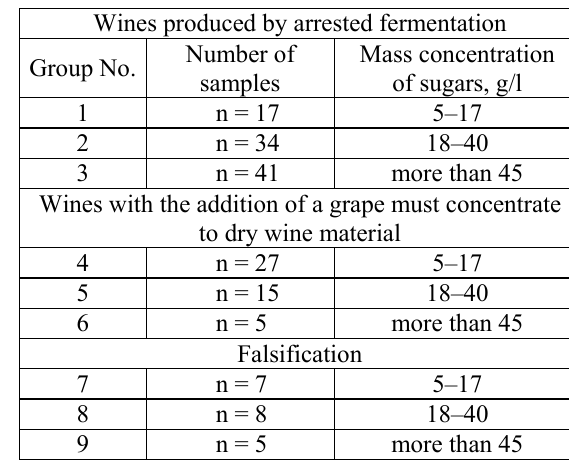
Table 2. Mass concentration of sugars in liqueur wines and their falsifications Group